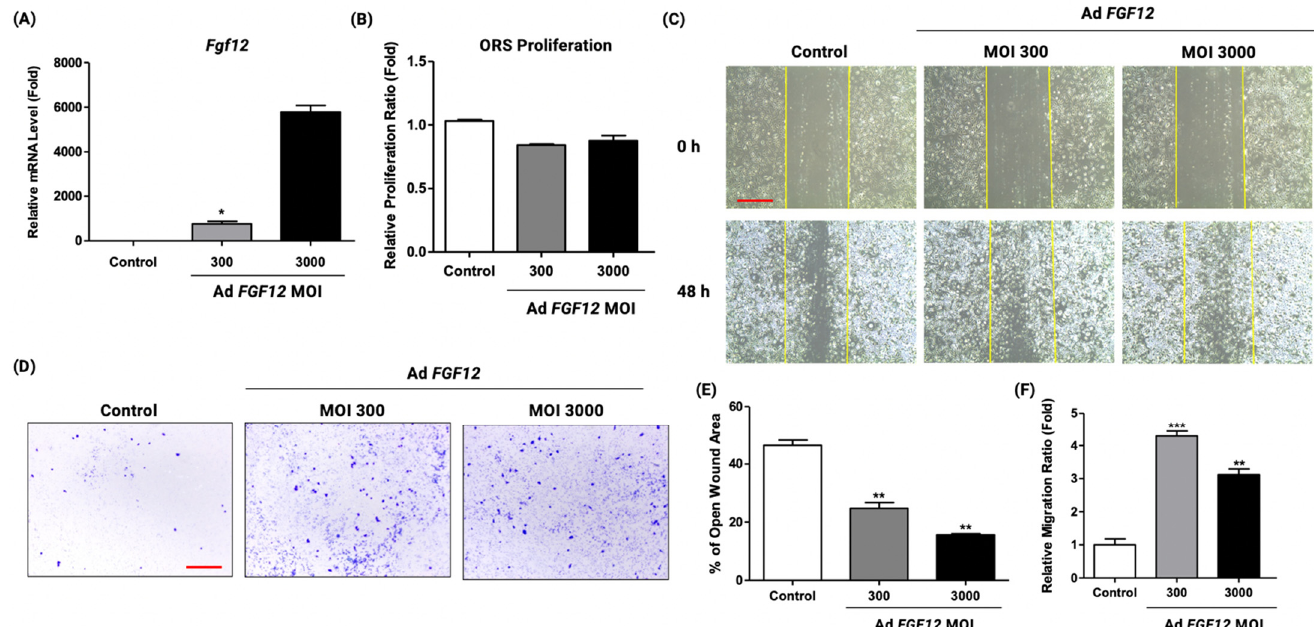
Figure 4. FGF12 overexpression by adenovirus infection promoted the migration of ORS cells. ( A ) Using FGF12 adenovirus, FGF12 was overexpressed in ORS cells at 300, 3000 multiplicities of infection (MOI). Adenovirus (Ad)-infected ORS cells were cultured for 72 h and the mRNA level of FGF12 at 300, 3000 MOI was determined by qRT-PCR. For the control group, Ad-LacZ was infected in ORS cells; n = 3. ( B ) The proliferation rate of ORS cells was measured; n = 3. Overexpression of FGF12 did not dramatically increase the rate of proliferation. ( C ) Wound-scratch assay was performed with Ad FGF12-infected ORS cells with various MOI. The migration of ORS cells was promoted at 300 and 3000 MOI of adenovirus infection compared to the control group; n = 3, scale bar=50 µ m. ( D ) Representative images of transwell migration assay upon FGF12 adenovirus infec- tion in ORS cells; n = 3, scale bar = 50 μ m. ( E ) Wound scratch assay results were quantified and represented as percentages of open wound area; n = 3. ( F ) Quantification of transwell migration assay indicated that ORS cell migration increased at the MOI of 300 and 3000. All data expressed as mean ± standard error (* p < 0.05, ** p < 0.01, *** p < 0.001 versus the control group).